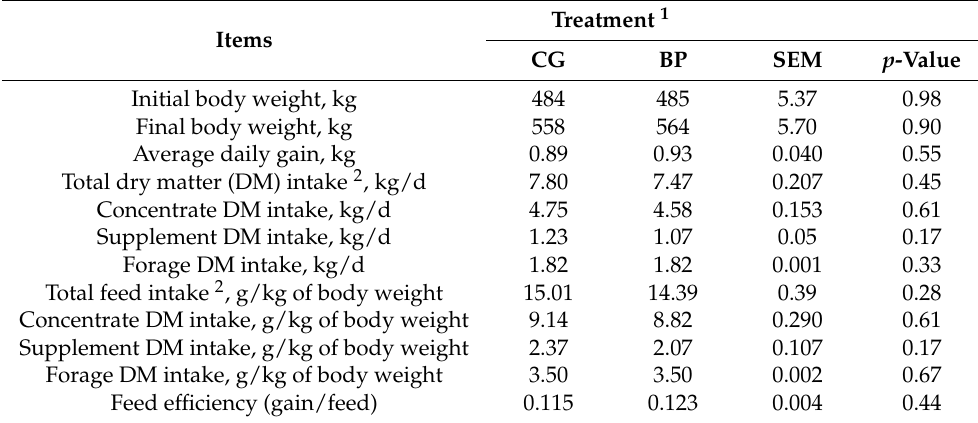
Table 2. Effects of feeding beet pulp in replacement of corn grain on growth performance of Korean cattle steers.